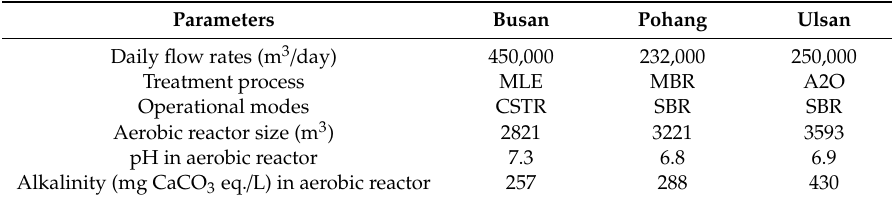
Table 2. Experimental conditions of wastewater treatment plants (WWTPs).